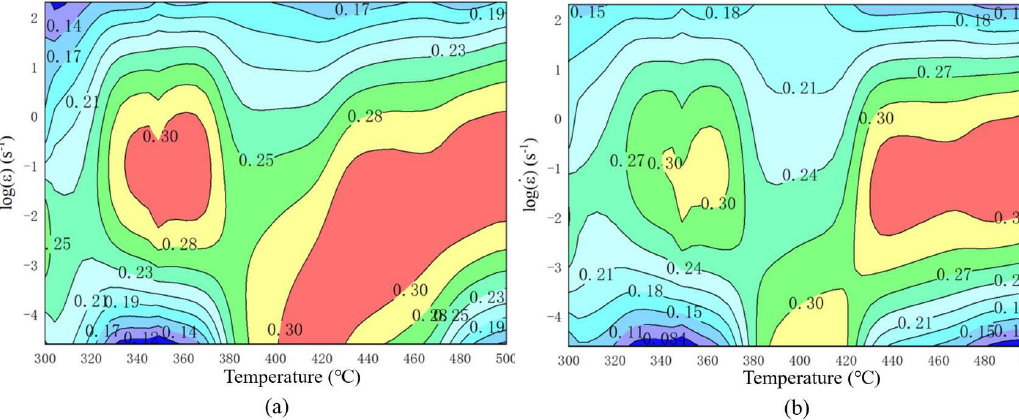
Figure 11. The power dissipation maps at the strain of (a) 0.5 and (b)